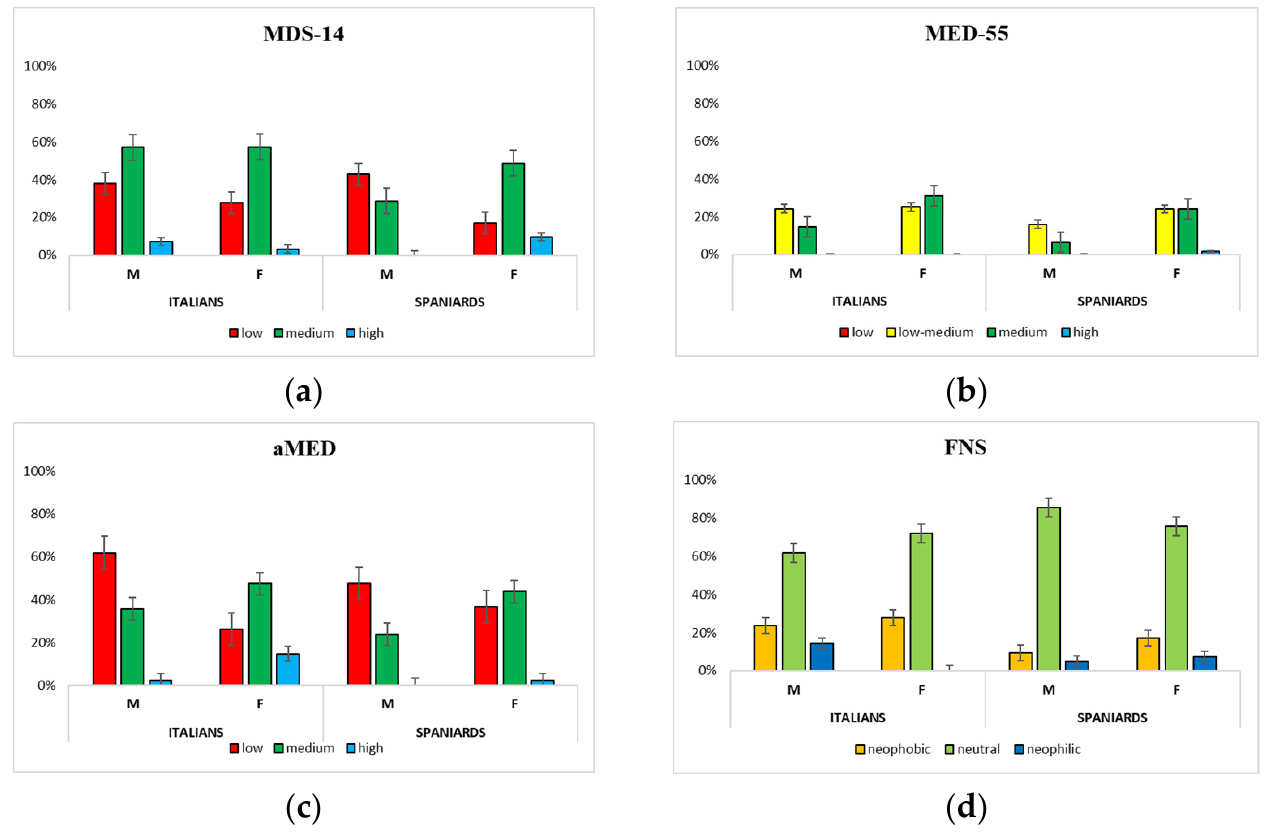
Figure 2. Distribution of the sample based on the adherence level to Mediterranean diet (MD) and the presence of food neophobia (FN). FNS: Food neophobia scale; MDS-14: Mediterranean diet score; MED-55: Mediterranean score; aMED: alternate Mediterranean diet score. Percentages of Italians and Spaniards who presented a low, medium, and high adherence grade to MD according to the MDS-14 ( a ), MED-55 ( b ), and aMED ( c ) scores; ( d ) Percentages of Italians and Spaniards who were neophobic, neutral and neophilic, according to the